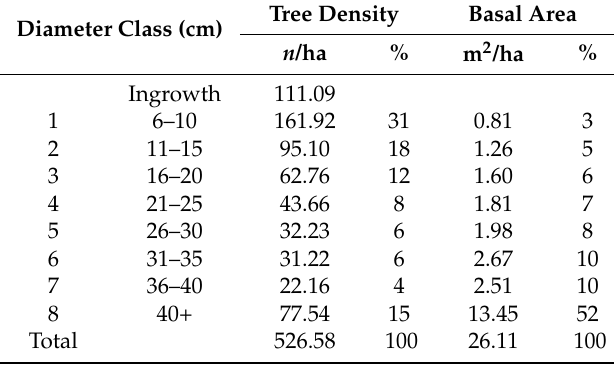
Table 4. Forest structure at the undisturbed